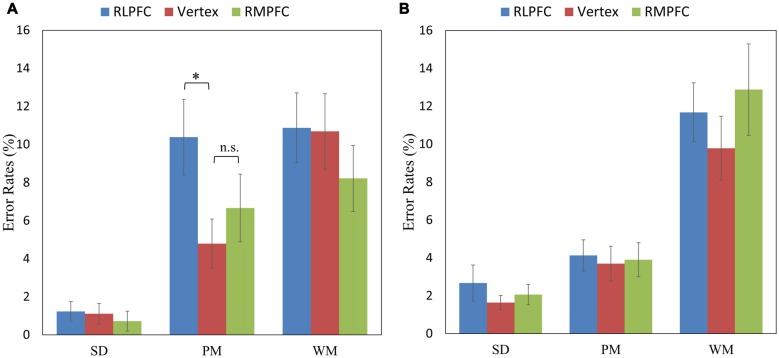
The mean error rates (ERs) of the switch trials (in the left panel A) and repeat trials (in the right panel B) across the three tasks (SD, PM and WM), and three stimulation sites: RLPFC (blue), vertex (red), RMPFC (green). *p < 0.05, n.s = non-significant. Error lines represent standard error of mean.